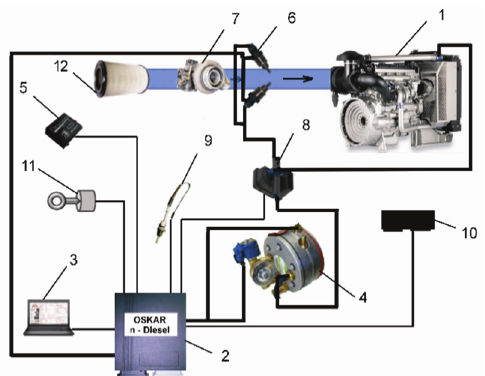
Table 1. Basic technical data of the Perkins 1104D-E44TA diesel engine Fig. 1. The flow chart of the natural gas fuelling system OSCAR-N DIESEL: 1 – Perkins 1104D-E44TA engine, 2 – controller of the engine gas fuelling system, 3 – computer, 4 – reducer, 5 – gas system switch, 6 – gas injectors, 7 – turbocharger, 8 – gas pressure regulator, 9 – temperature sensor, 10